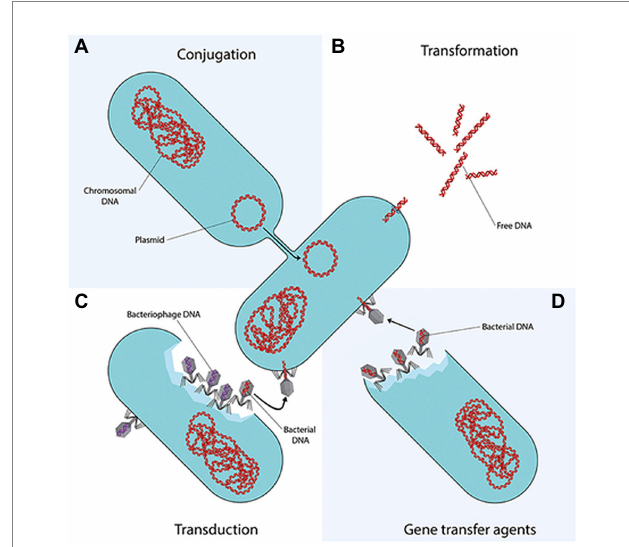
FIGURE 1 Horizontal gene transfer (HGT) of ARBs and ARGs (Von Wintersdorff et al., 2016). Conjugation is the direct transfer of DNA molecule known as a plasmid from a donor bacterium to a recipient bacterium, involving cell-to-cell contact between the two bacteria. Transduction is the transfer of DNA from a donor bacterium to a recipient bacterium, through viruses that infect bacteria, known as bacteriophages. Transformation is intra- and inter-species exchange of genetic information by uptake of naked DNA, released through cell lysis or actively excreted by some bacteria which can only be received by a competent bacterium. Following uptake and translocation to the cytoplasm, it is incorporated into the competent bacterium’s chromosome or into a plasmid (Koutsoumanis et al., 2021; Uluseker et al., 2021; Courti et al.,